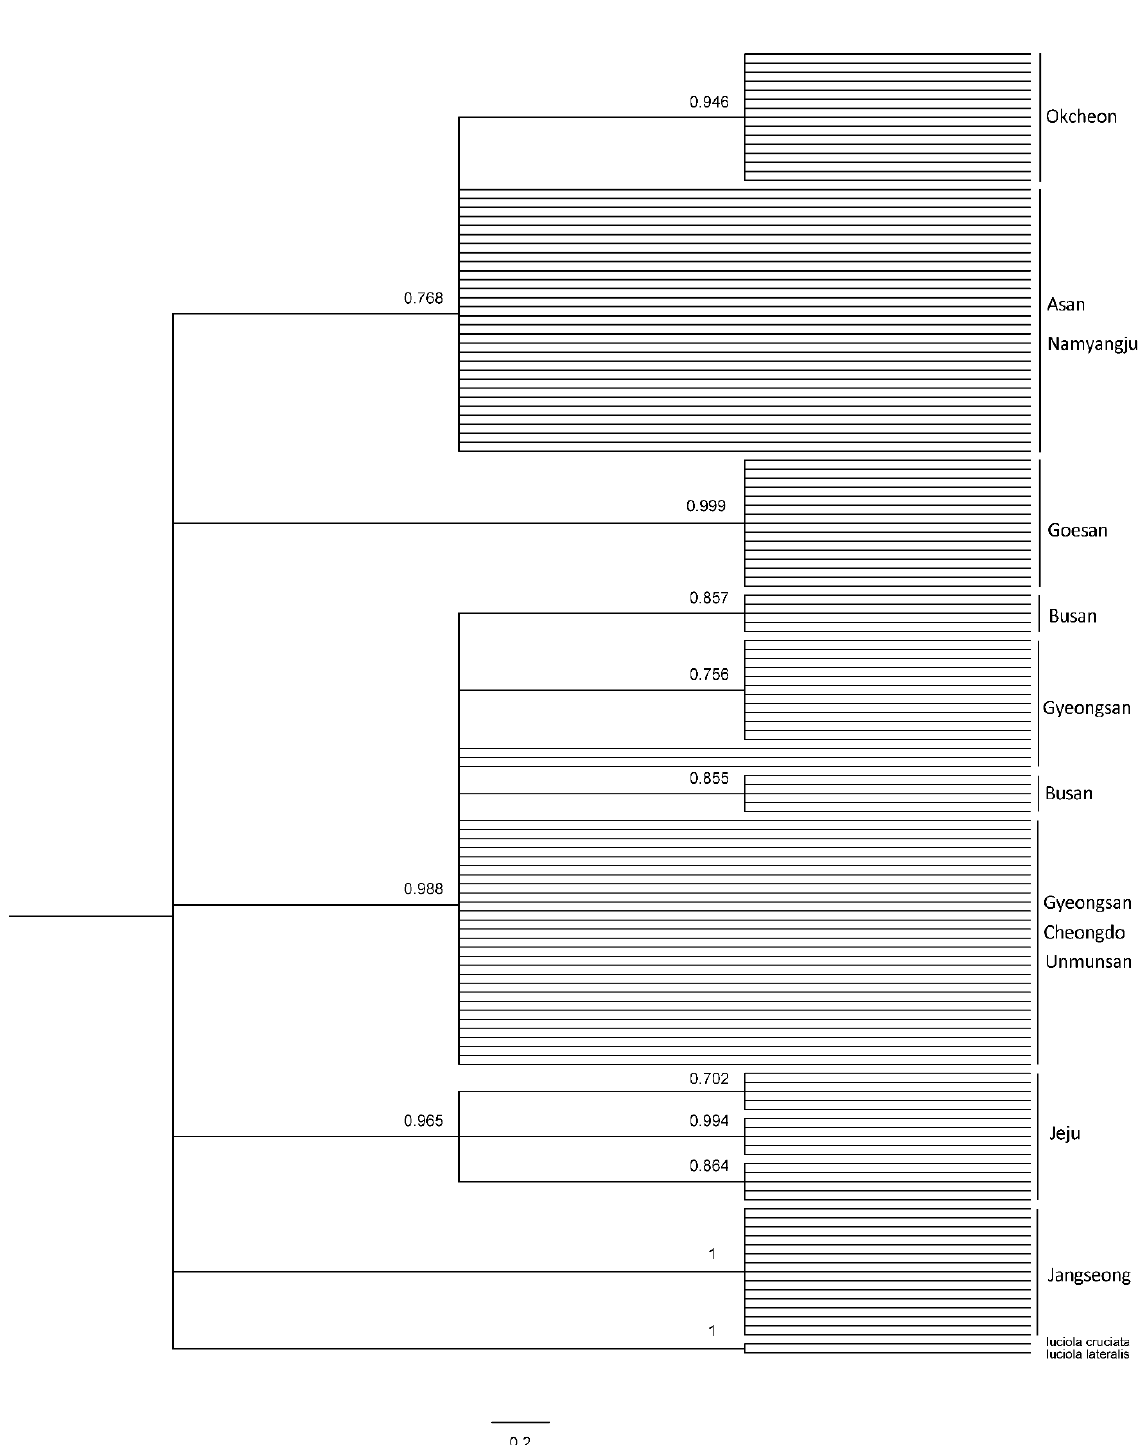
Figure 9. Phylogenetic analysis of 27 mitochondrial COII gene of L. unmunsana . The tree was developed by the ML method using the MEGA software.